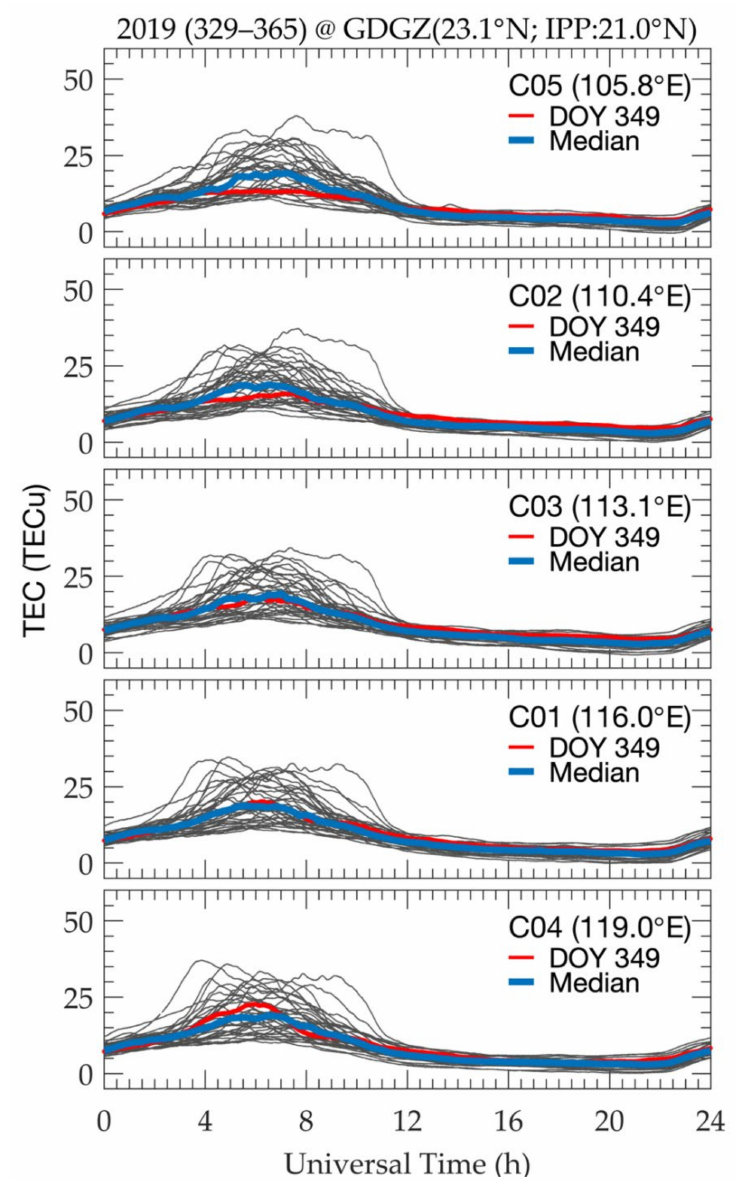
Figure 2. The daily GEO TEC recorded at GDGZ during DOY 329–365 in 2019. In each panel the red curve marks the data of each of the IPPs on 15 December (DOY 349), and the blue line plots the medians during the